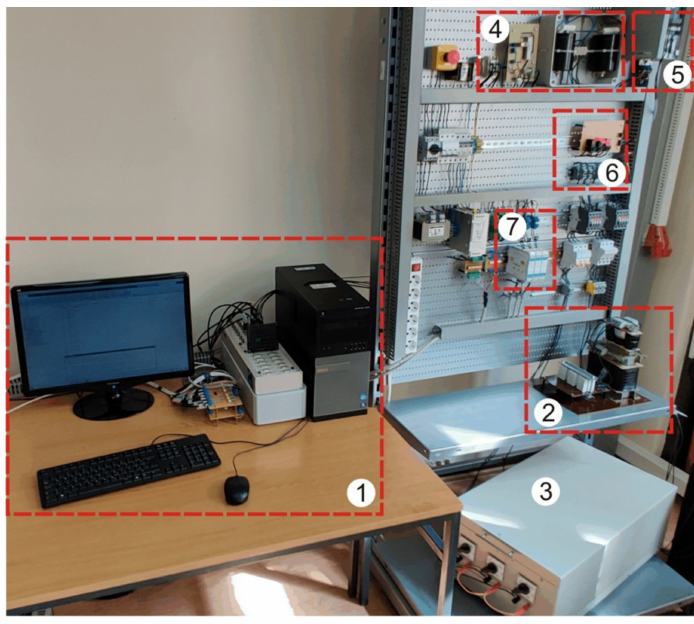
Figure 8. Experimental setup details at Niš University: 1—PC with dSpace DS1103; 2—LCL filter; 3—Variable load; 4—DC source; 5—grid inverter; 6—Current sensors; 7—Voltage sensors.